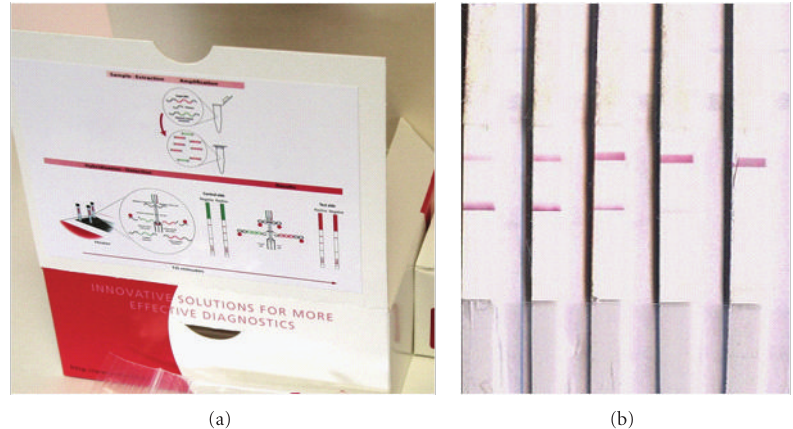
Figure 2: (a) sample Oligo-C test produced for diagnosis of HAT or Leishmaniasis by Coris Bioconcept. (b) results of NASBA-OC on T. b. rhodesiense cases from Eastern Uganda. Extreme left and right are the positive and negative controls, respectively. The 2 samples next to the positive control were clearly